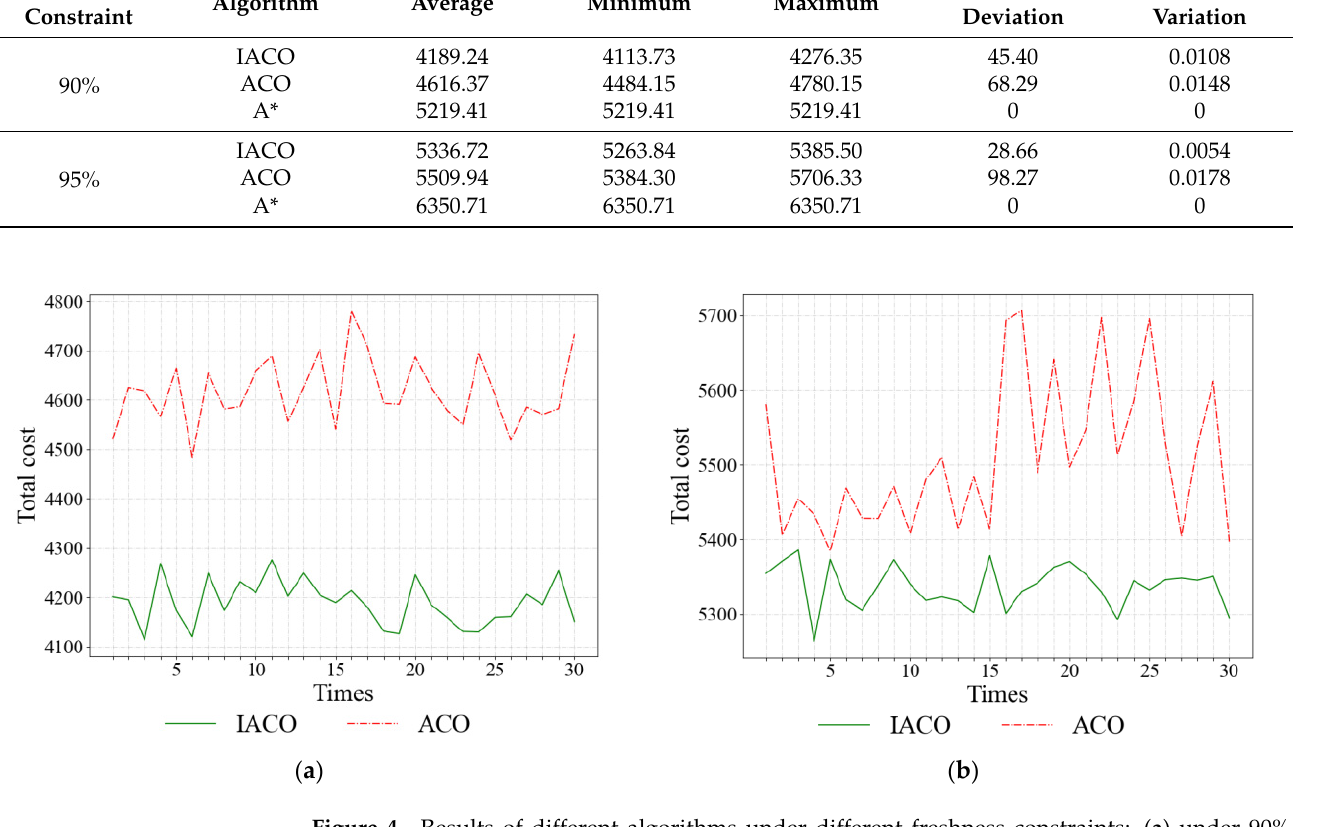
Figure 4. Results of different algorithms under different freshness constraints: ( a ) under 90%, ( b ) under 95%.